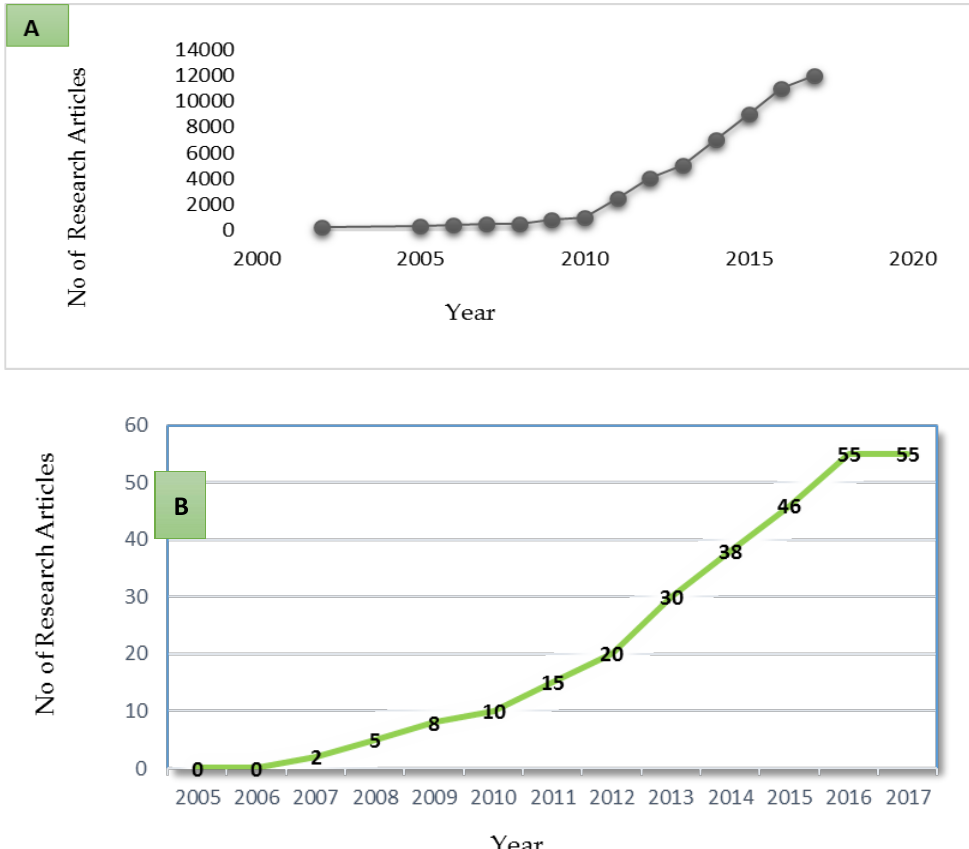
Figure 4. ( A ) Overview of the research publications of viral metagenomic studies around the world, ( B ) Overview of the publication of viral metagenomic studies in Africa.